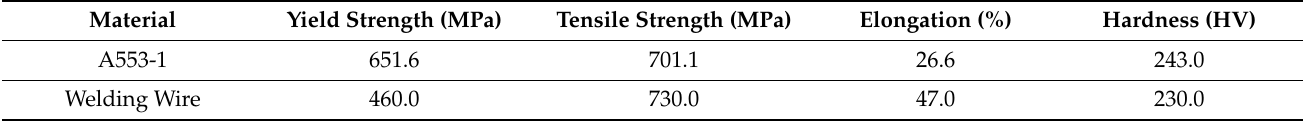
Figure 2. Schematic diagram for the flux cored arc welding process [7]. Table 1. Mechanical properties of base metal [7].